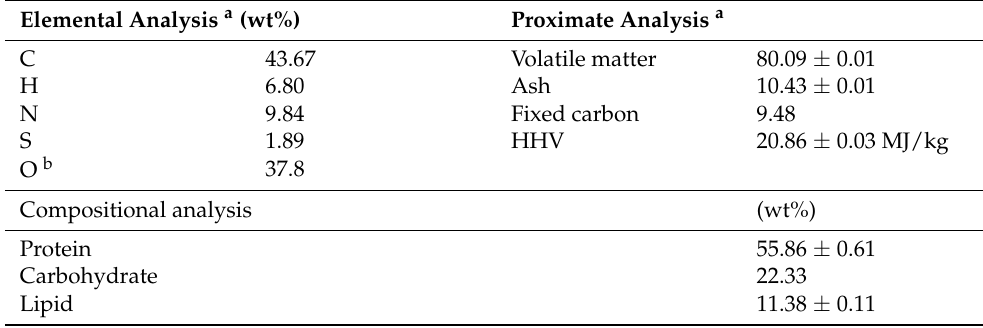
Table 2. Characterization of dried Spirulina platensis